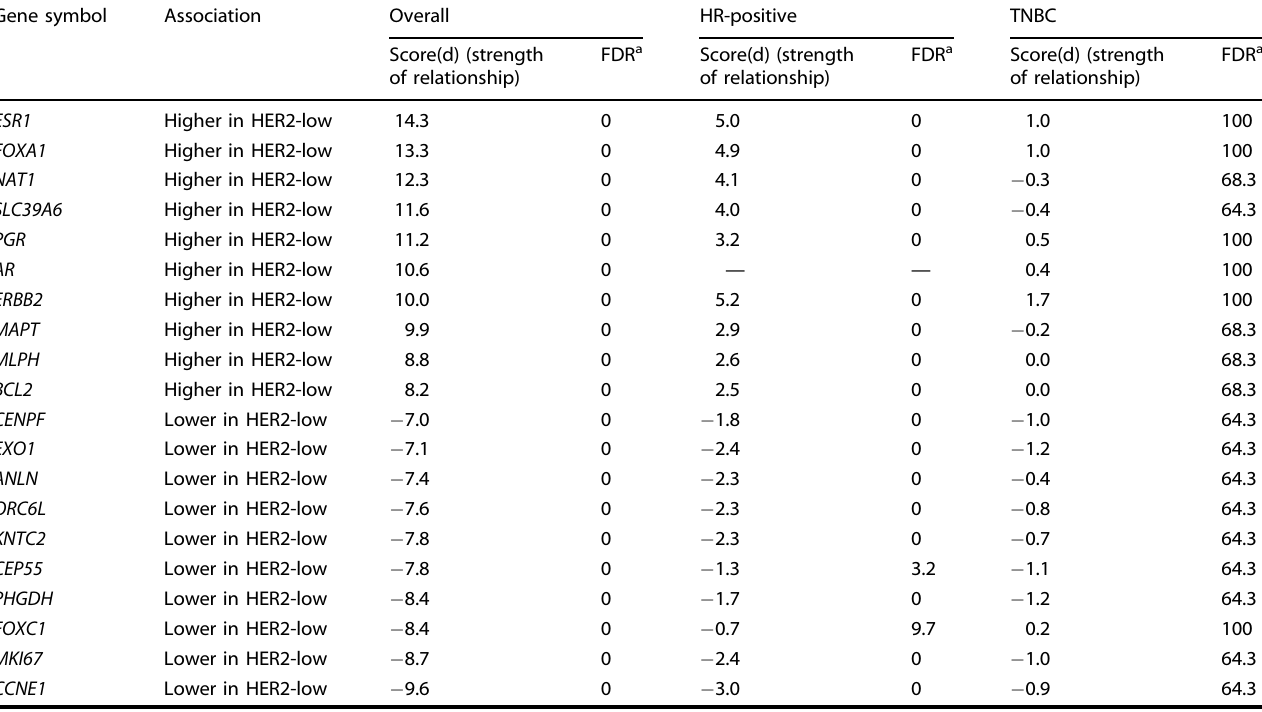
Table 4. Top 20 differentially expressed genes between HER2-low and HER2 0 disease. Gene symbol